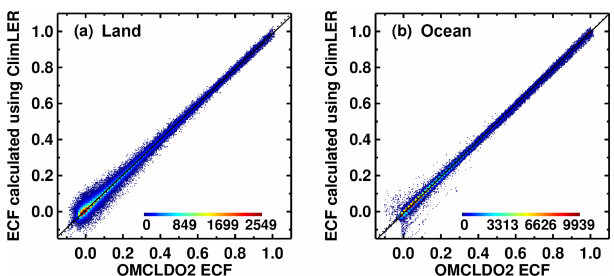
Figure 6. ECFs retrieved with our algorithm versus those retrieved from OMCLDO2. Results are provided as 2-D densities in ECF bins of 0.01. The color scale represents the number of OMI pix- els falling within a given bin. Data for 13 November 2006, 30 ◦ S– 30 ◦ N. (a) Land; (b) ocean.